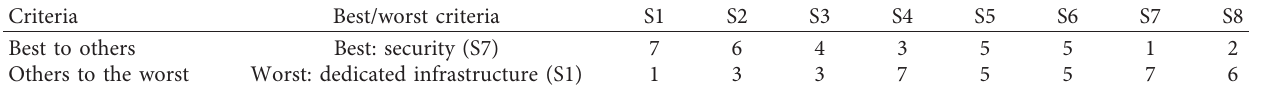
Table 5: Internal strengths (IS)-pairwise comparison vector.